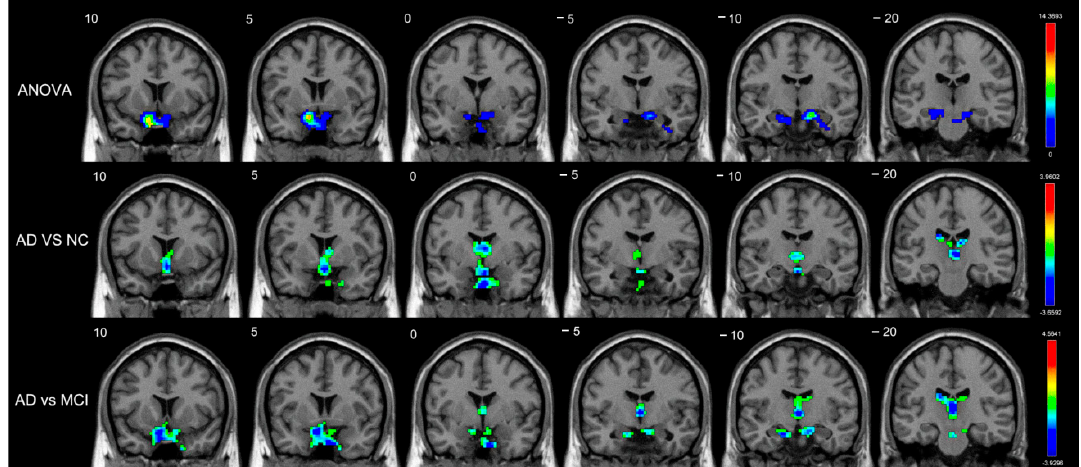
Figure 1. Brain regions with significant differences in short ‐ range FCDs (voxel ‐ level p < 0.01, cluster ‐ level p < 0.05, GRF ‐ corrected) among the AD, MCI, and NC groups. There were significant among ‐ group differences in the short ‐ range FCD in the right amygdala. Decreased short ‐ range FCDs in patients with AD compared with normal controls were located in the bilateral caudate. Decreased short ‐ range FCDs in patients with AD compared with patients with MCI were located in the bilateral caudate. In addition to the DMN networks, long ‐ range FCDs of the basal ganglia (including the bilateral caudate, the right amygdala, the right pallidum, and the right putamen) were found to be significantly different in the among ‐ groups analysis. Compared with normal controls, patients with MCI had increased long ‐ range FCDs in the bilateral amygdala, the left putamen, and the right pallidum, whereas patients with AD had reduced long ‐ range FCDs in the left caudate and the right pallidum, with a lower threshold (voxel ‐ level p < 0.05 and cluster ‐ level p < 0.05, corrected by GRF [23]) (Table S1). Additionally, the long ‐